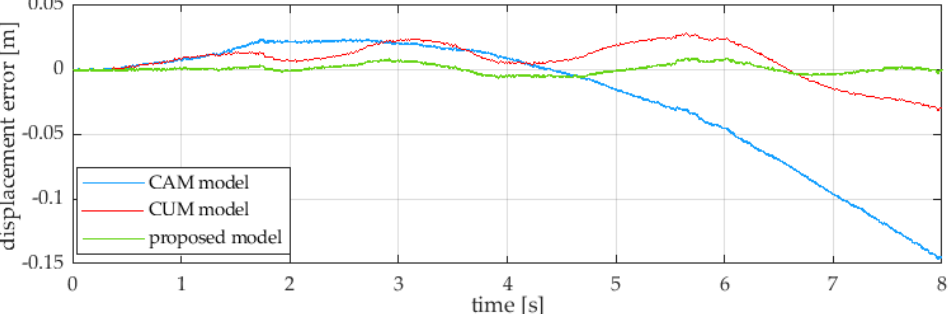
Figure 6. Absolute errors of ball displacement as a function of time for the considered numerical models.